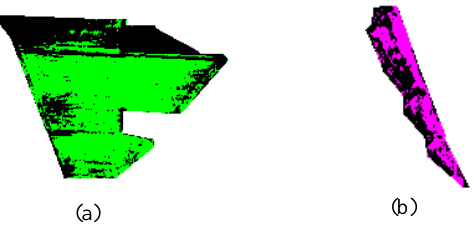
Figure 8. Result of multi-evidence based classification approach (Black are misclassified pixels. Other region represents pixels that are correctly classified)